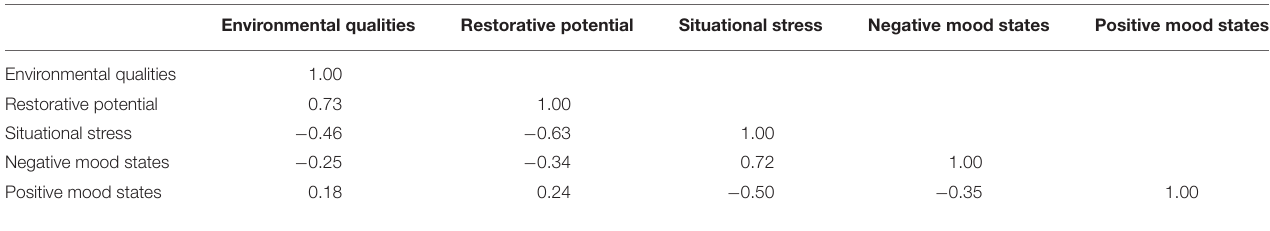
TABLE 8 | Latent variables correlation matrix. Environmental qualities Restorative potential Situational stress Negative mood states Positive mood states Environmental qualities 1.00 Restorative potential 0.73